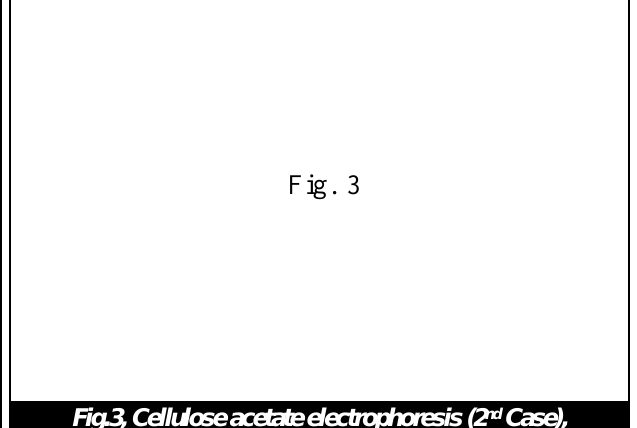
Fig.3, Cellulose acetate electrophoresis (2 nd Case), showing strong S band.